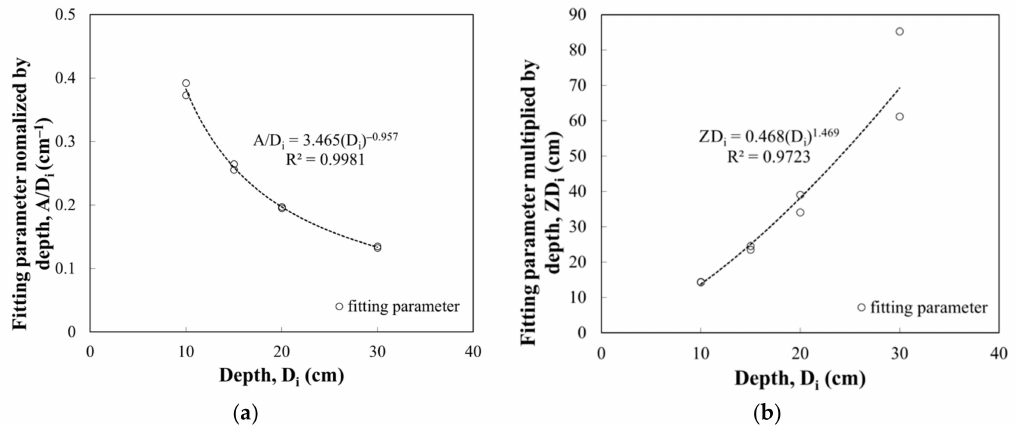
Figure 8. Correlations between fitting parameters ( A and Z ) and depth ( D i ). ( a ) Relationship between A/D i and D i ; and ( b ) relationship between ZD i and D i .